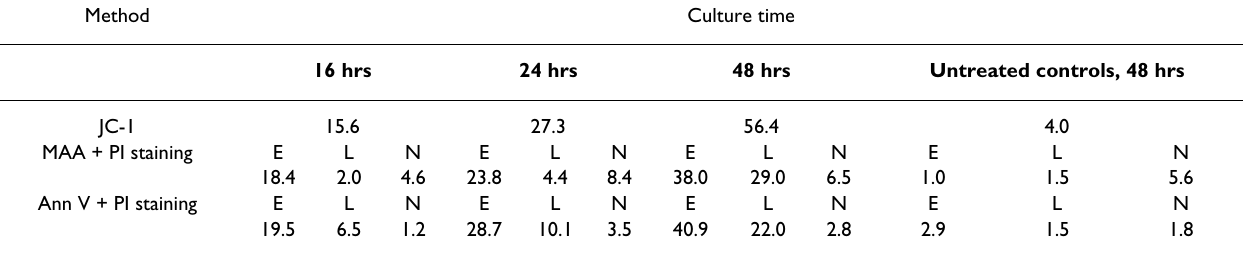
Table 2: Percentage of apoptotic cells: comparison of results obtained with different methods in the U937 myelomonocytic cell line